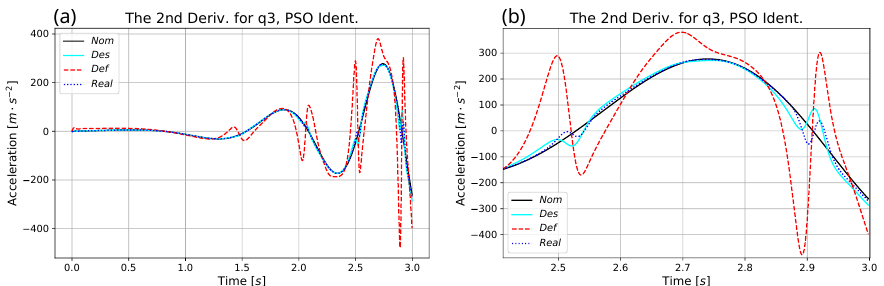
Figure 22. Second time derivatives for q 3 ( a ) and the zoomed-in excerpt ( b ) during the parameter identification